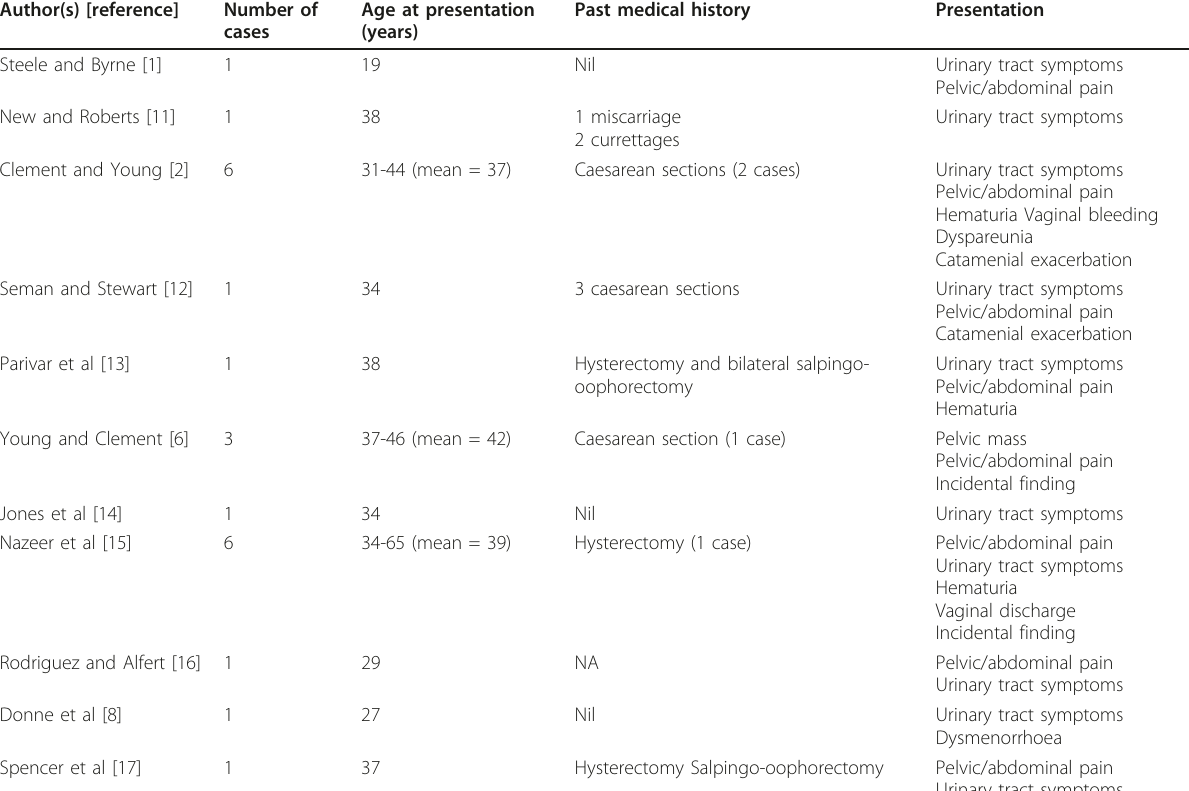
Table 2 Clinical presentation of bladder lesions with presence of